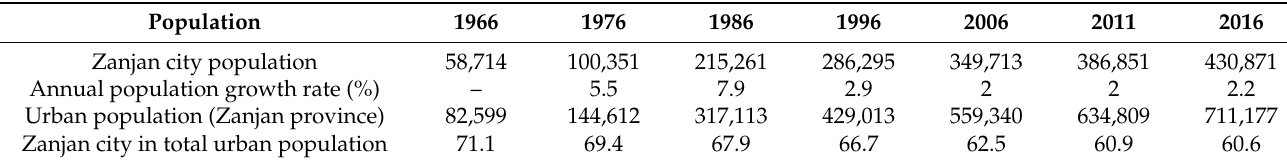
Table 1. Total population of Zanjan city and urban population of the respective province, Iran in selected years between 1966 and